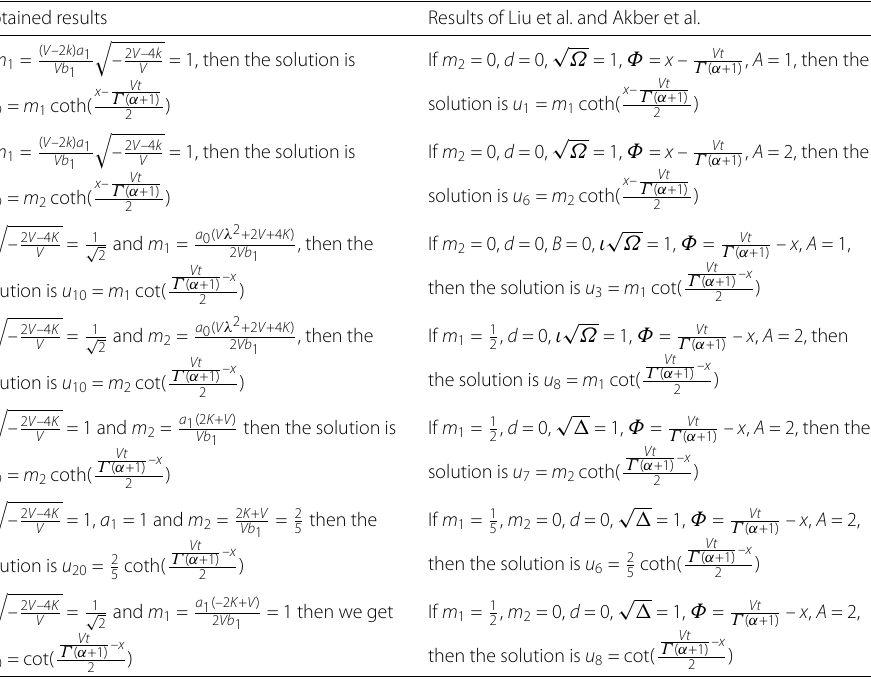
Table 2 Comparing the results of Mohyud-Din et al. [17] and Najafi et al. [30] with our results Obtained results Results of Najafi et al. and Mohyud-Din et al.